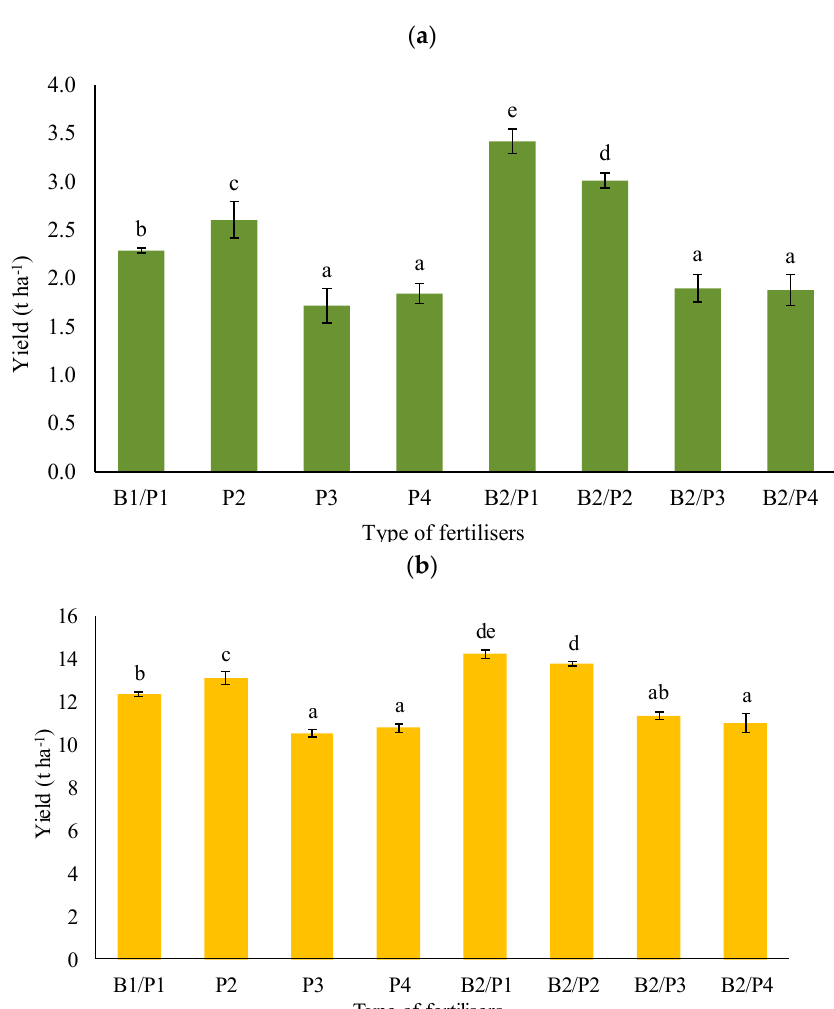
Figure 5. Yield of basket willow at the end of the first ( a ) and second ( b ) year of cultivation in relation to the fertiliser applied. The mean values marked with the same letter do not differ significantly at a level of α ≤ 0.05 based on the results of the Bonferroni test.